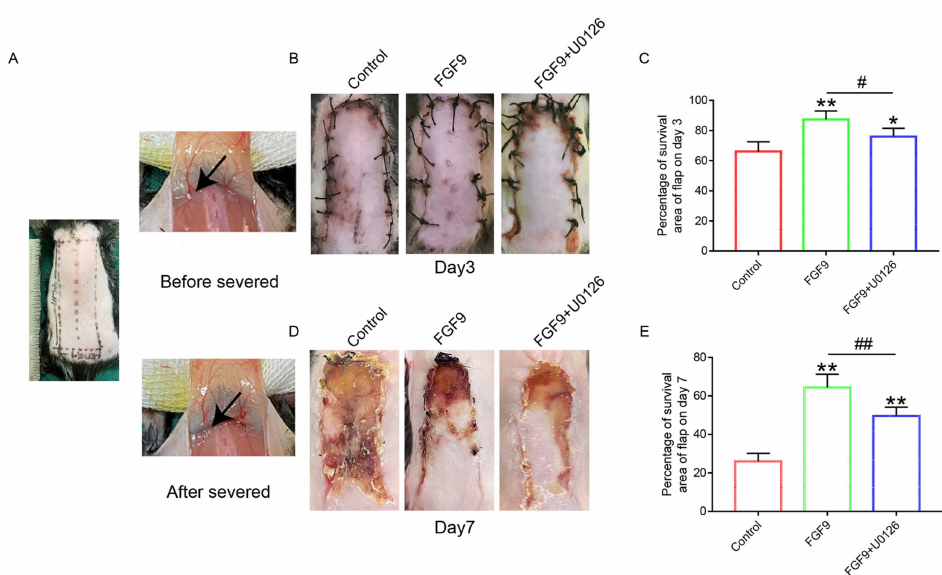
Figure 1. FGF9 application directly elevated the flaps’ survival area. ( A ) Photographs of flap and modeling area before and after vascular blockage. The black arrow refers to the part where the blood vessel is cut off ( B , D ) Photographs reporting the survival of flap at 3 and 7 days following to operation in control, FGF9, and FGF9+U0126 groups (3 days: 66.00%, 86.67%, and 76.17%; 7 days: 26.0%, 64.5%, and 49.7%, respectively). ( C , E ) Graph of the skin flap stock region percentage at 3 and 7 days for each group. The data are presented as the mean values ± SD, n = 3. * and ** indicate p < 0.05 and p < 0.01 against the control group, respectively; # and ## indicate p < 0.05 and p < 0.01 comparing the FGF9 group to the FGF9+U0126 group, respectively indicating statistical